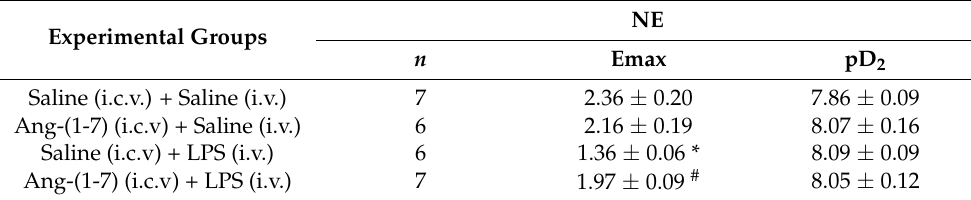
Figure 5. Central Ang-(1-7) restored vascular hyporesponsiveness in endotoxemic rats. Effect of central Ang-(1-7) (0.3 nmol in 2 µ L, i.c.v.) in vascular reactivity of the thoracic aorta to NE in the absence ( A ) or presence of aminoguanidine, a NOS2 selective inhibitor (100 µ mol/L) ( B ), and AVP (1 nmol/L) ( C ) in rats 6 h after LPS administration (1.5 mg/Kg, i.v.). Data are expressed as the mean ± SEM, n = 5–7. ANOVA, followed by Bonferroni post-hoc test. * p < 0.05 versus Saline (i.c.v.) + Saline (i.v.) group and # p < 0.05 versus Saline (i.c.v) + LPS (i.v.) group. Table 2. Values of maximum constrictor effect (Emax) and pD 2 obtained from concentration-response curves in response to NE in thoracic aorta rings of control or endotoxemic rats treated or not with Ang-(1-7).